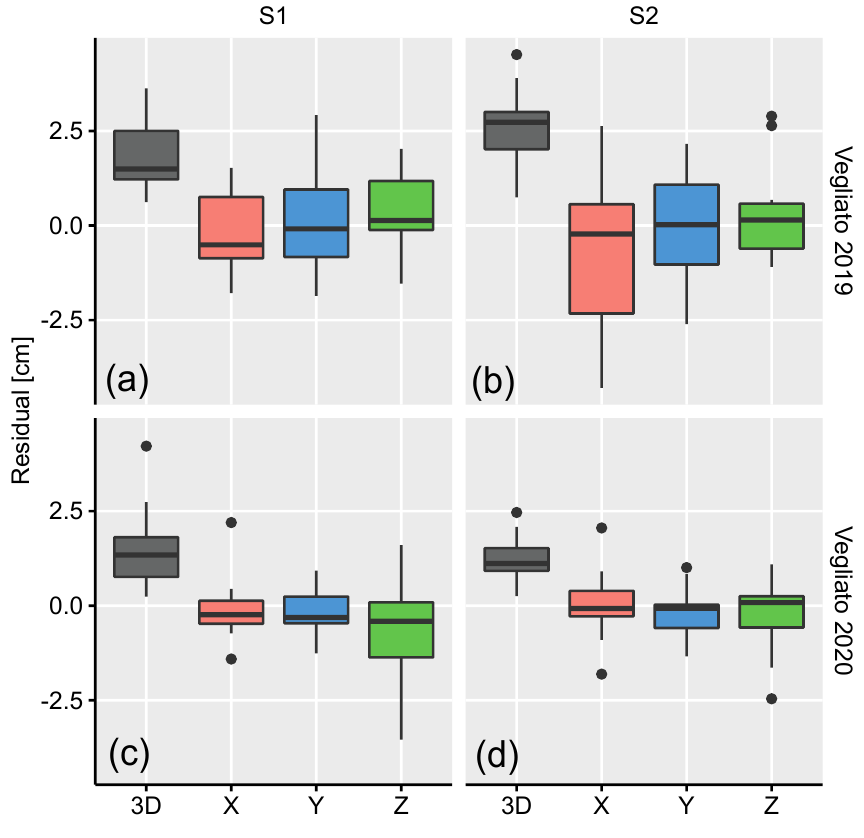
Figure 9. Comparison of CPs residuals for Vegliato study area using manual ( a , b ) or programmed ( c , d ) flight mode. Sony camera was employed for data acquisitions. The 3D total error is reported in gray, while pink, blue and green represents residuals in the X , Y and Z direction,